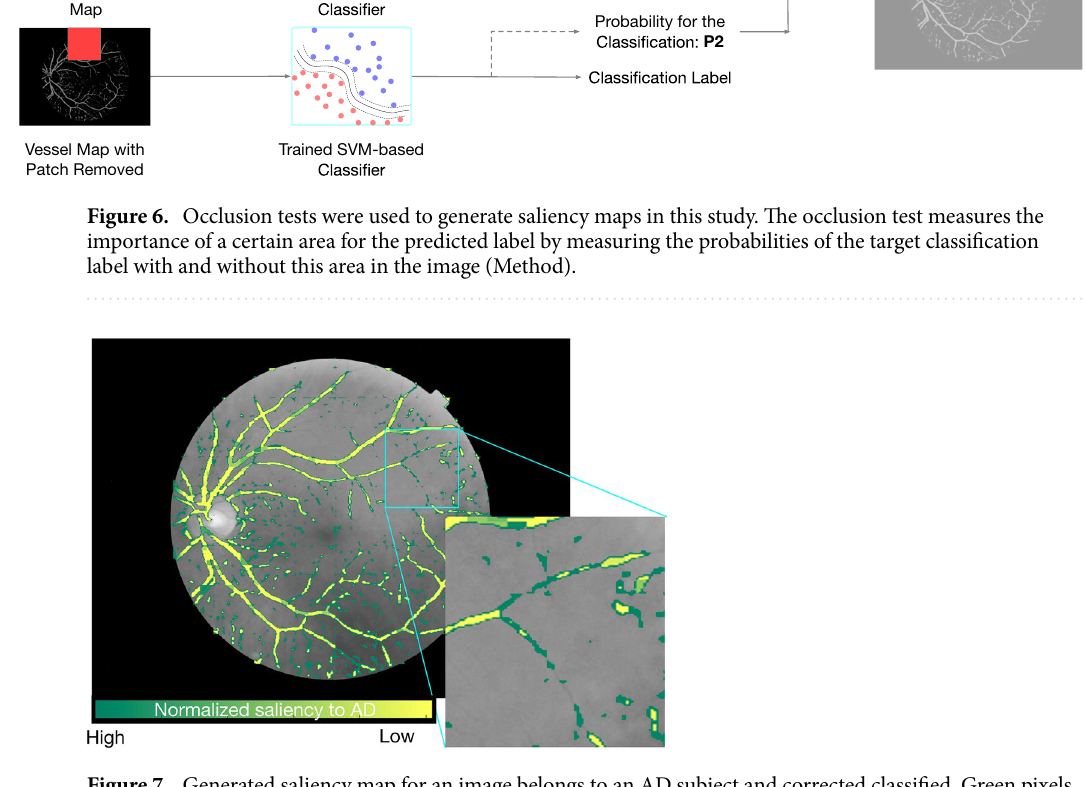
Figure 7. Generated saliency map for an image belongs to an AD subject and corrected classified. Green pixels are more salient for classifying AD, while yellow pixels do not significantly contribute to this classification result. According to this saliency map, small vessels and capillary vessels are more important in determining whether this image belongs to an AD